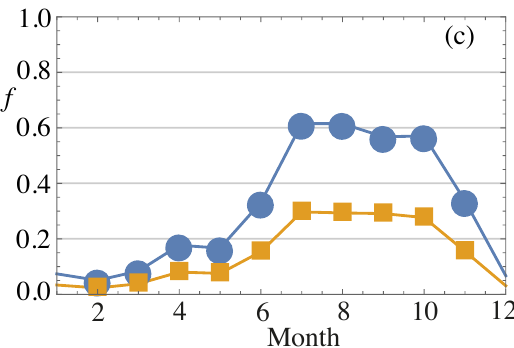
Figure 12. Monthly comparison between recuperated and non-recuperated plant layouts for an example case: plant located in Salamanca, with an objective power output of 30 kWe. ( a ) Monthly energy production; ( b ) overall plant efficiency; and ( c ) solar share.